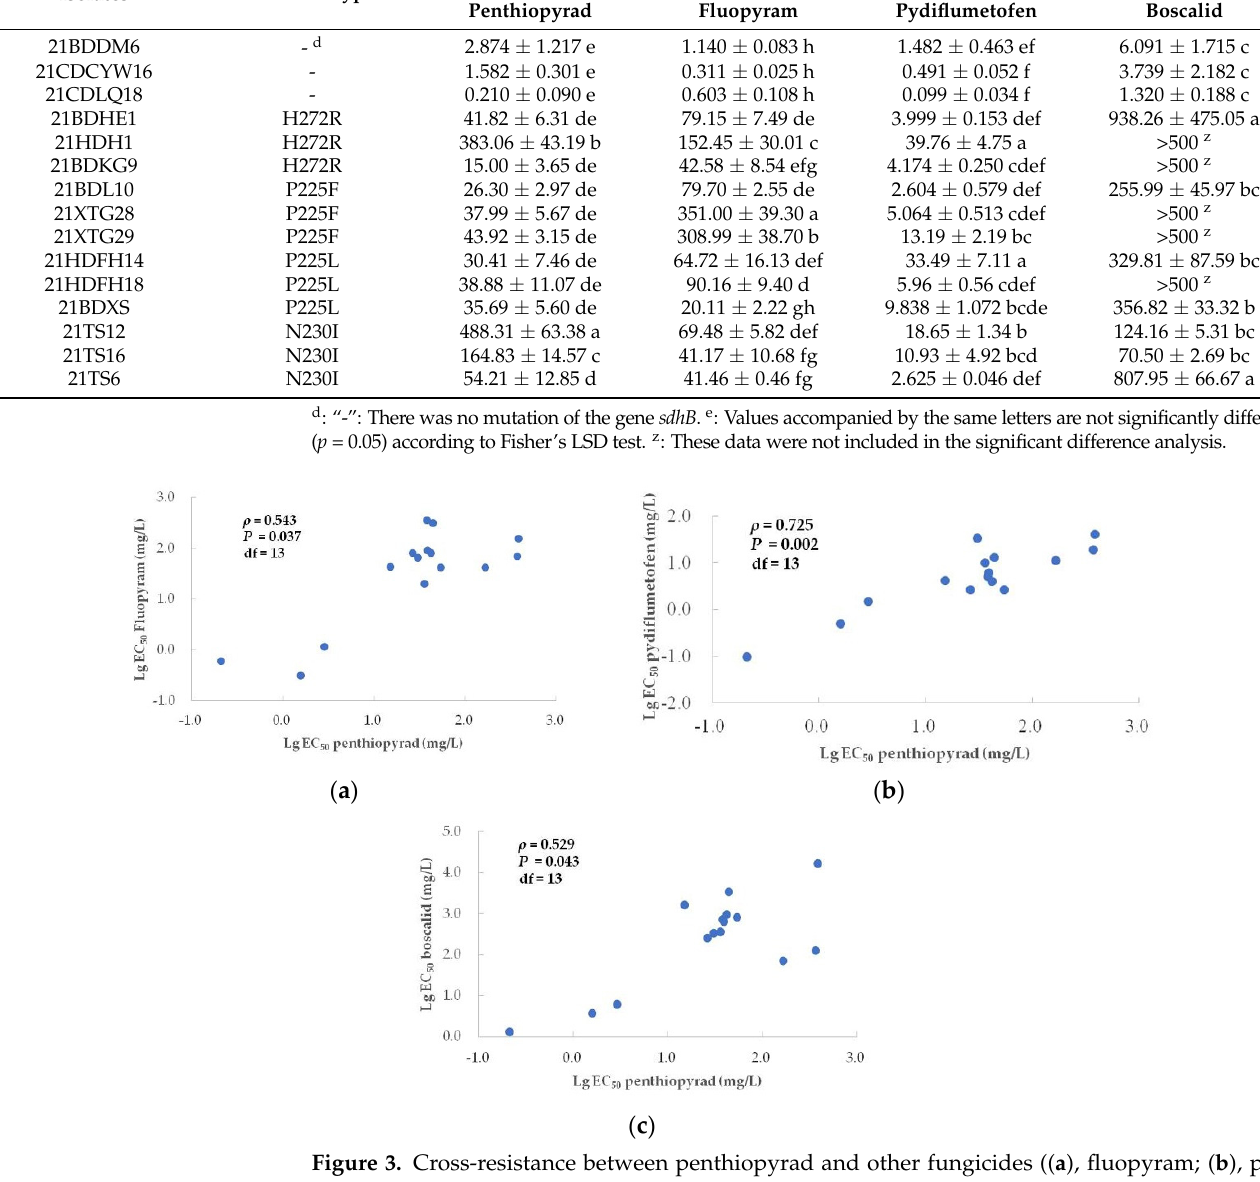
Table 5. The EC 50 values of four SDHI fungicides against three B. cinerea isolates with no mutation and 12 isolates with four different mutations (H272R, P225F, P225L and N230I) of the gene sdhB .